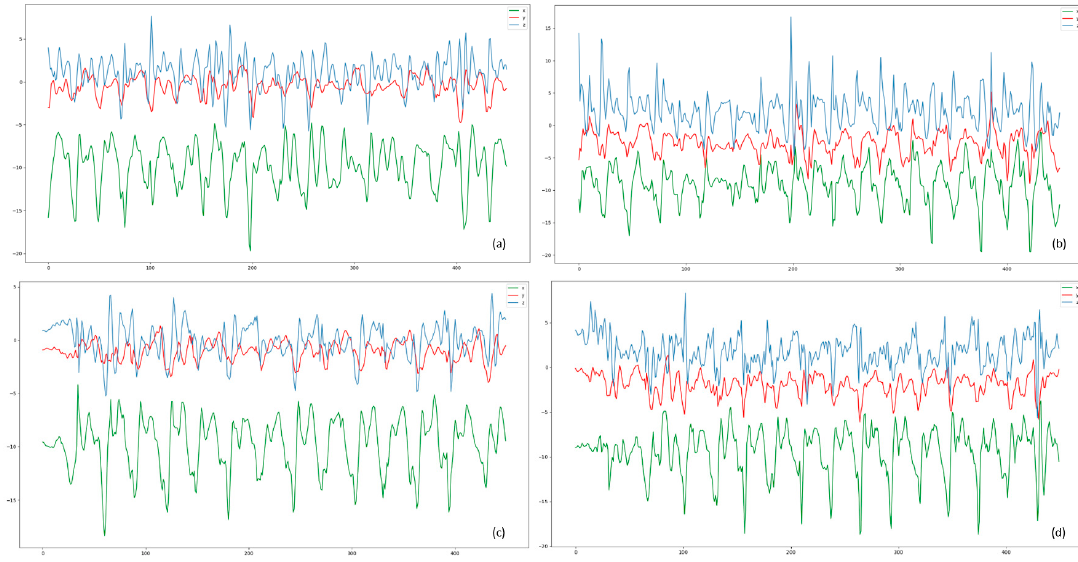
Figure 1. The curve of data from acceleration. ( a ) User A downstairs. ( b ) User B downstairs. ( c ) User